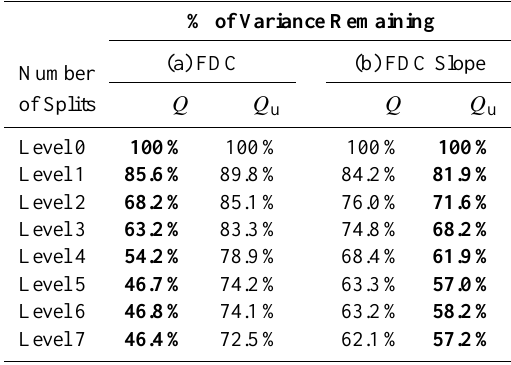
process. Table 4. Variance reduction in FDC quantiles (a) and slopes (b) sorted by catchment